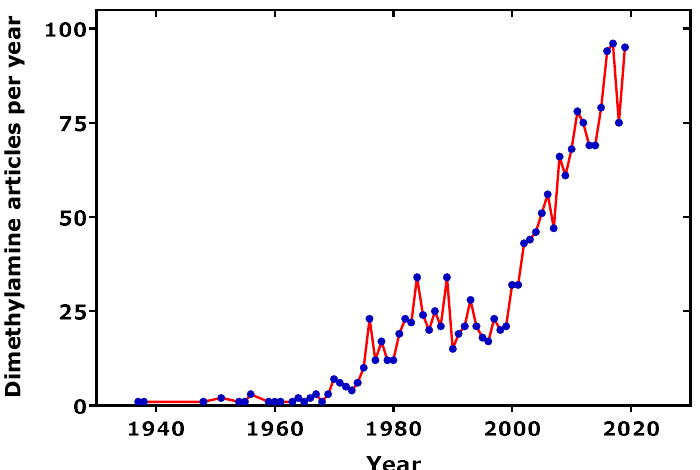
Figure 1. Number of dimethylamine-related articles published per year, as found in the PubMed (ncbi.nlm.nih), using the term “dimethylamine”. One average, 10% of the articles are related to urine.